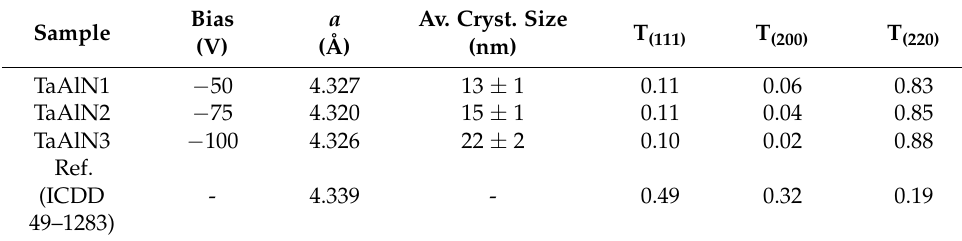
Table 2. Microstructure parameters estimated from XRD analyses.